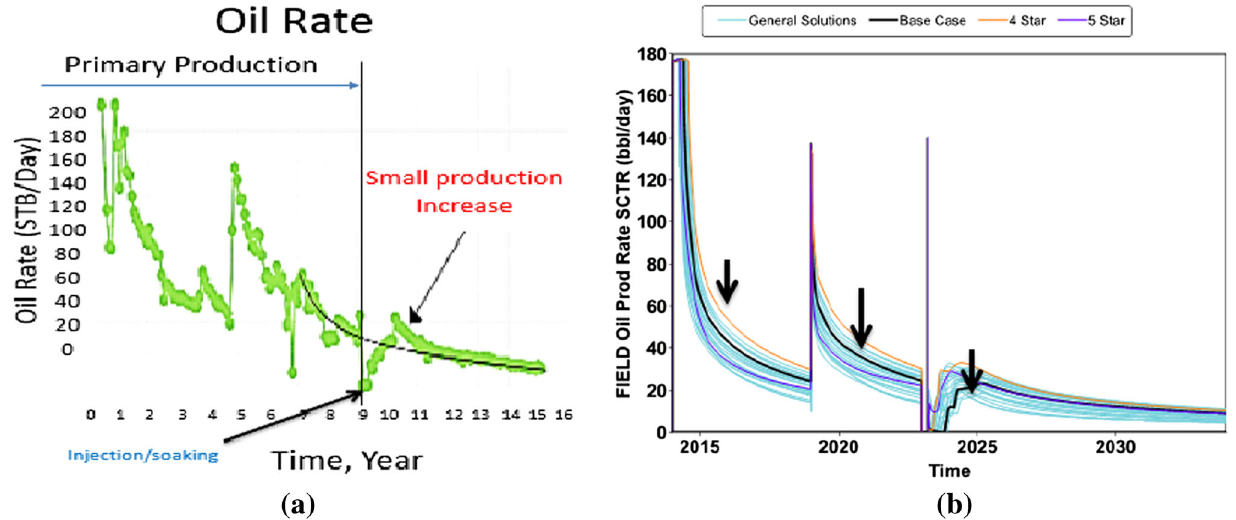
Fig. 19 a CO 2 pilot test#2 (Hoffman and Evans 2016). b History match from the simulated